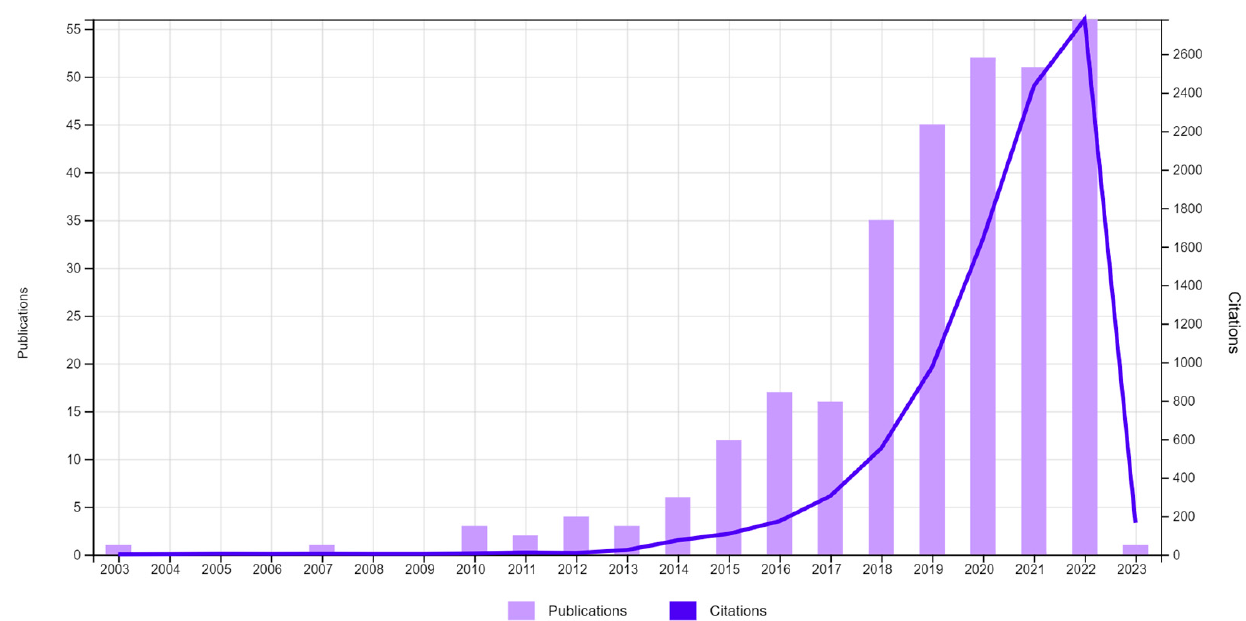
Figure 1. Annual number of publications and citations related to “lignin” and “drug delivery” in the last two decades: data obtained from Web of Science, 13 February 2023.